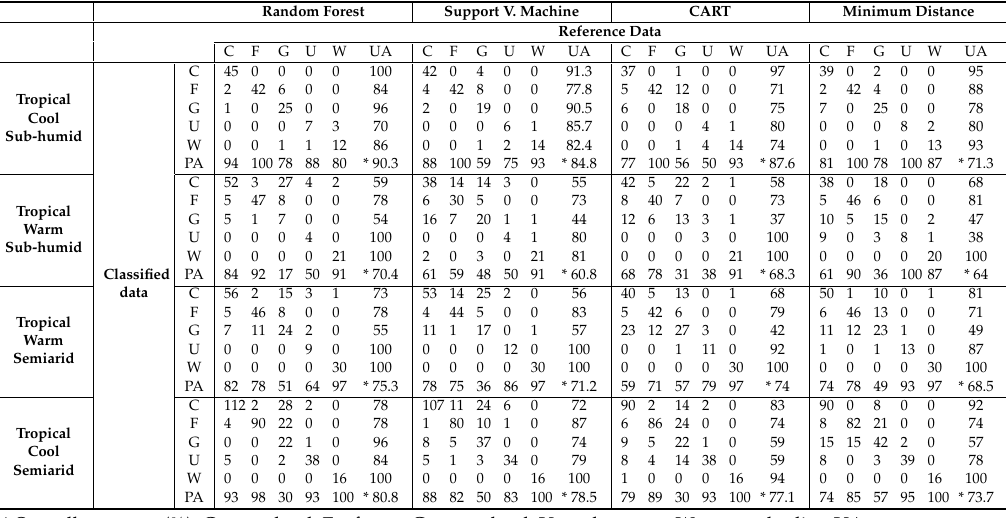
* Overall accuracy (%); C—cropland; F—forest; G—grassland; U—urban area; W—water bodies; UA—user accuracy (%); PA—producer accuracy